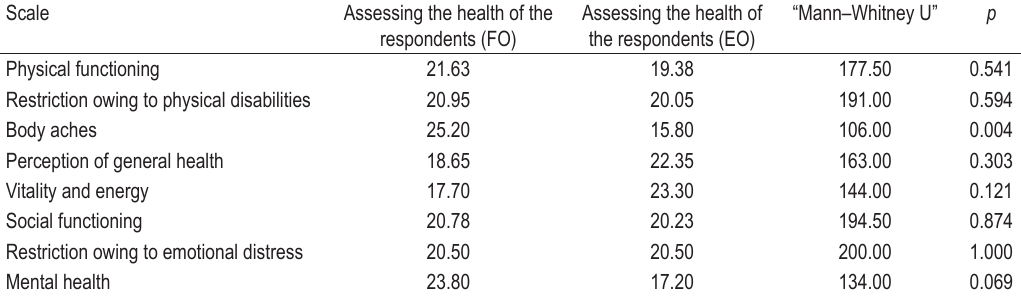
TABLE 2. Type of surgery and health status of respondents (Mann–Whitney U test)